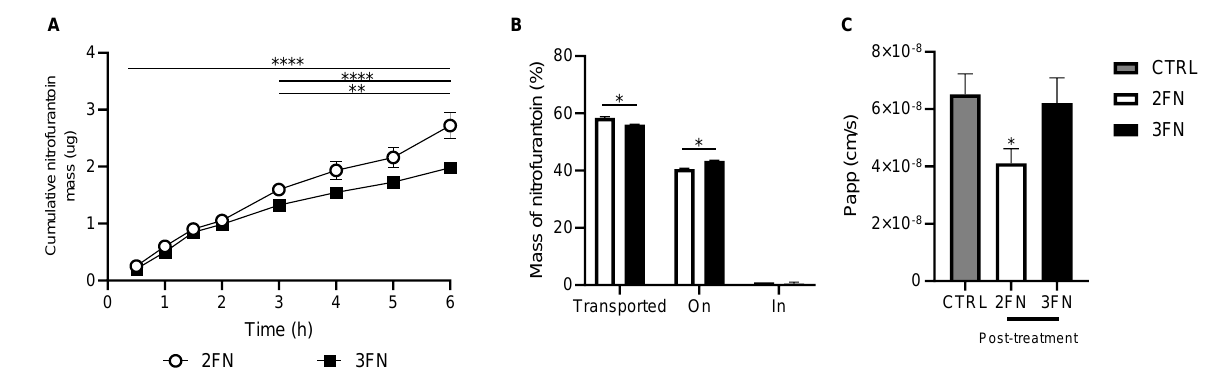
Figure 7. Transport of 2FN and 3FN spray-dried formulations. ( A ). Cumulative mass of nitrofurantoin transported across H441 ALI cultures for 2FN and 3FN formulations. ( B ). Percentage of the total mass of NF transported (shown as Transported), remaining on the apical layer (On) and inside the cells (In) at the end of 6h transport study ( C ). Comparison of apparent permeability (Papp) of ALI cultures for 2FN and 3FN formulations post-treatment (6 h) with untreated cells (control). ( n = 3, mean ± SD) (* p < 0.05, ** p < 0.01, **** p < 0.0001) using two-way ANOVA with Tukey’s posthoc test).